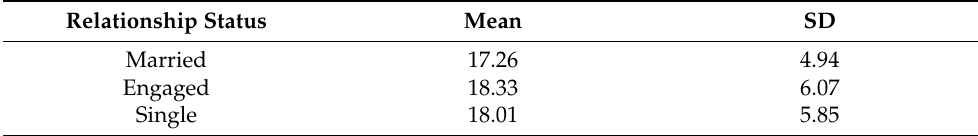
Table 3. GH12 scores (mean and SD) according to the relationship